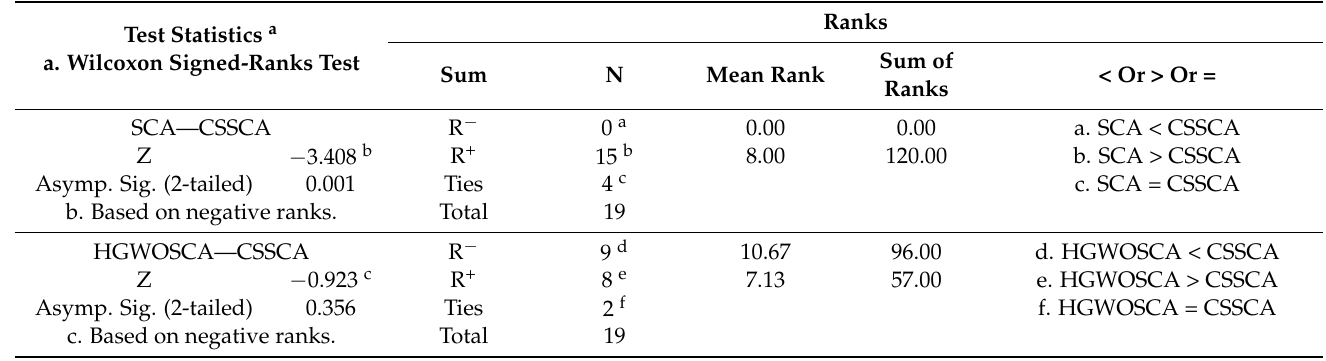
Table 3. The 19 test functions’ Wilcoxon signed-ranks test